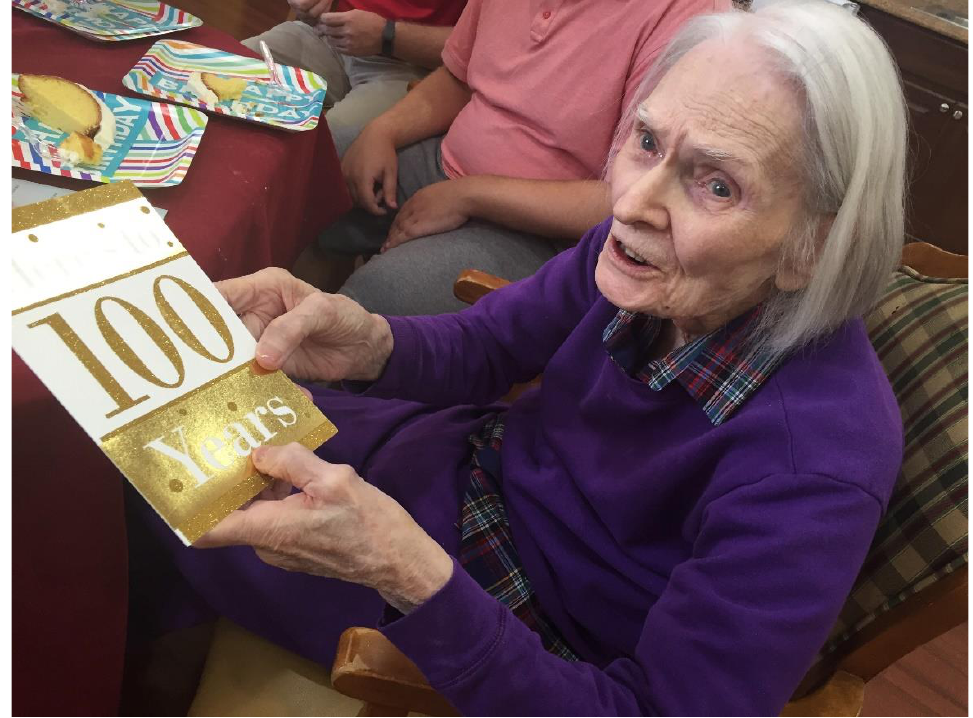
Figure 10: Mimi Thornton turning 100: “her life also had purpose and meaning as Dona’s caregiver, and this might have contributed to her longevity.” Courtesy: Sophie